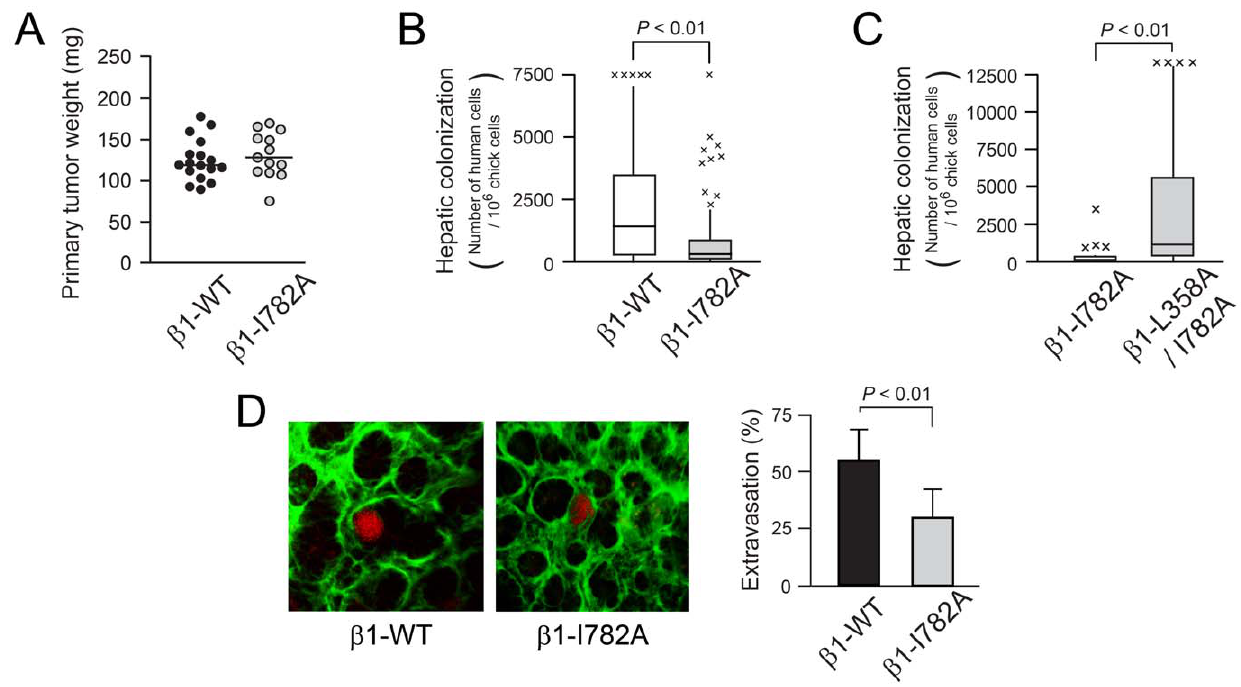
Figure 3. Inside-out activation of b 1 integrin is required for hepatic colonization by tumor cells. (A) In vivo tumor growth assay on the chick chorioallantoic membrane. Tumors growing on the membrane were weighed seven days after inoculation of 10 6 b 1-WT (n=18) or b 1-I782A MDA-MB435 cells (n=13). (B and C) Box plots showing the number of tumor cells colonized to the chick liver five days after intravenous injection. (B) b 1-WT (n=34) and b 1-I782A cells (n=28) and (C) b 1-I782A (n=28) and b 1-L358A/I782A cells (n=32). (D) Tumor cell extravasation from liver sinusoids. Twenty-four hours after intravenous injection of tumor cells labeled with tdTomato (red), chick embryo livers were imaged using a two-photon microscope after labeling hepatic vasculature with FITC-lectin (green). Representative images of livers from embryos injected with b 1-WT or b 1-I782A tumor cells depict an extravasated cell in the left panel and intravascular cell in the right panel. Three-dimensional images were digitally reconstructed and the percentage ( 6 SEM) of extravasated cells was quantified ( b 1-WT: 222 cells, b 1-I782A: 142 cells; six independent